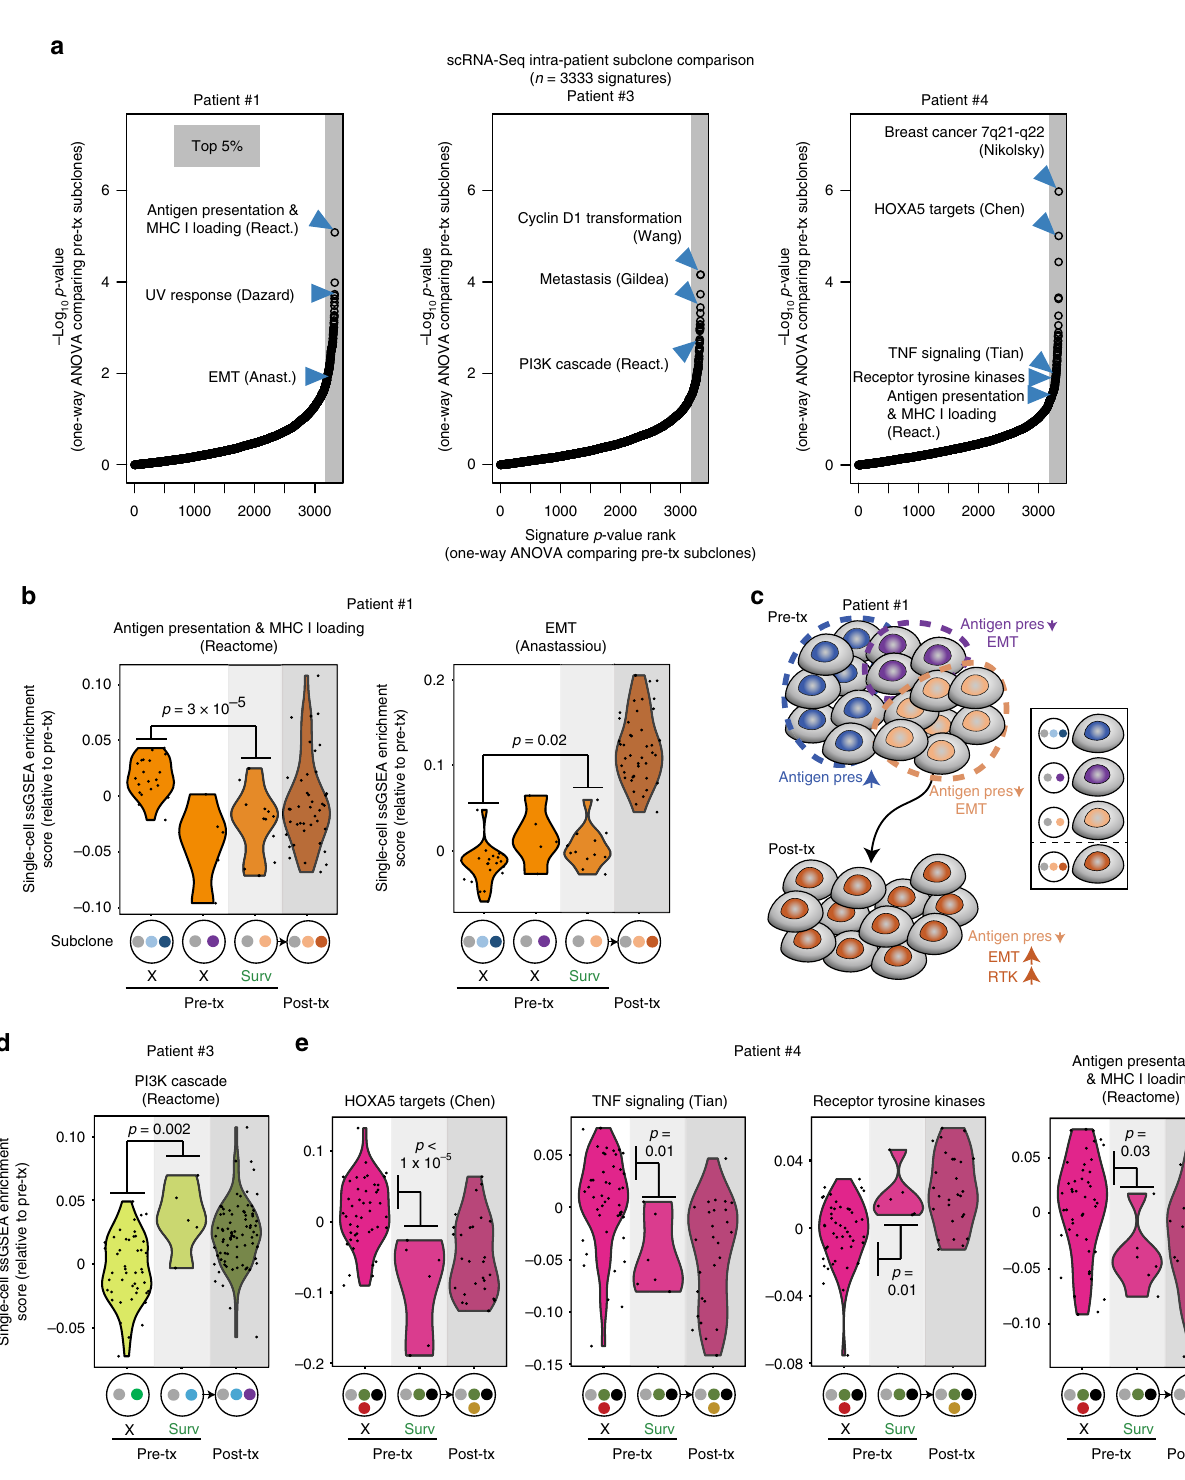
Fig. 6 Pre-existence of post-treatment phenotypes in pre-treatment survivor subclones. a Plots of P -values (one-way ANOVA) comparing scRNA-Seq ssGSEA enrichment scores for 3331 C2 signatures, plus the receptor tyrosine kinases (all-58) signature and our anti-apoptosis signature, between subclones in each indicated patient ’ s pre-treatment sample. x -axis, P -value ranks (higher ranks are more signi fi cant); y -axis, − log 10 ( P -value). b Patient #1 ssGSEA enrichment scores for single cells in each pre-treatment subclone, with post-treatment cells shown for comparison and the dominant post- treatment subclone indicated. Each dot represents a single cell. P -values are by Student ’ s t -test. Subclones correspond to those shown in Fig. 2a. “ X ” indicates disappearing subclone while “ Surv ” indicates the subclone giving rise to the post-treatment sample. c Schematic showing subclonal phenotypic heterogeneity and evolution in pre-treatment patient #1 cells. d As in b but for patient #3. Subclones correspond to those in Fig. 2c. e as in b but for patient #4, with subclones as shown in Fig.